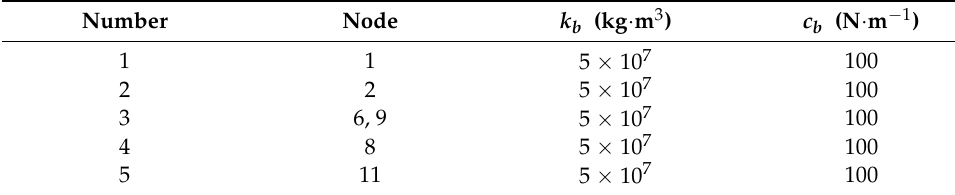
Table 3. Bearing parameters for the dual-rotor-bearing system.